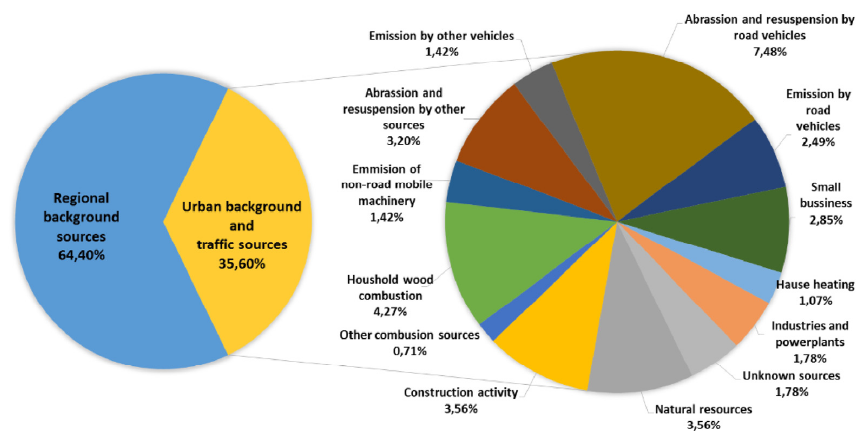
Figure 1. Source apportionment of PM 10 in Berlin [14].